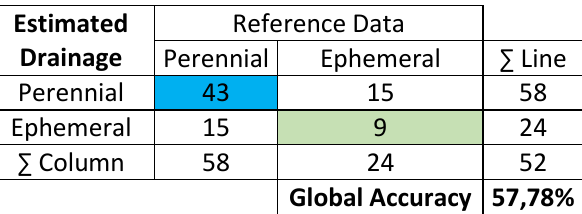
Table 4 – Accuracy Assessment of Estimated Drainage in Jaguaruna.